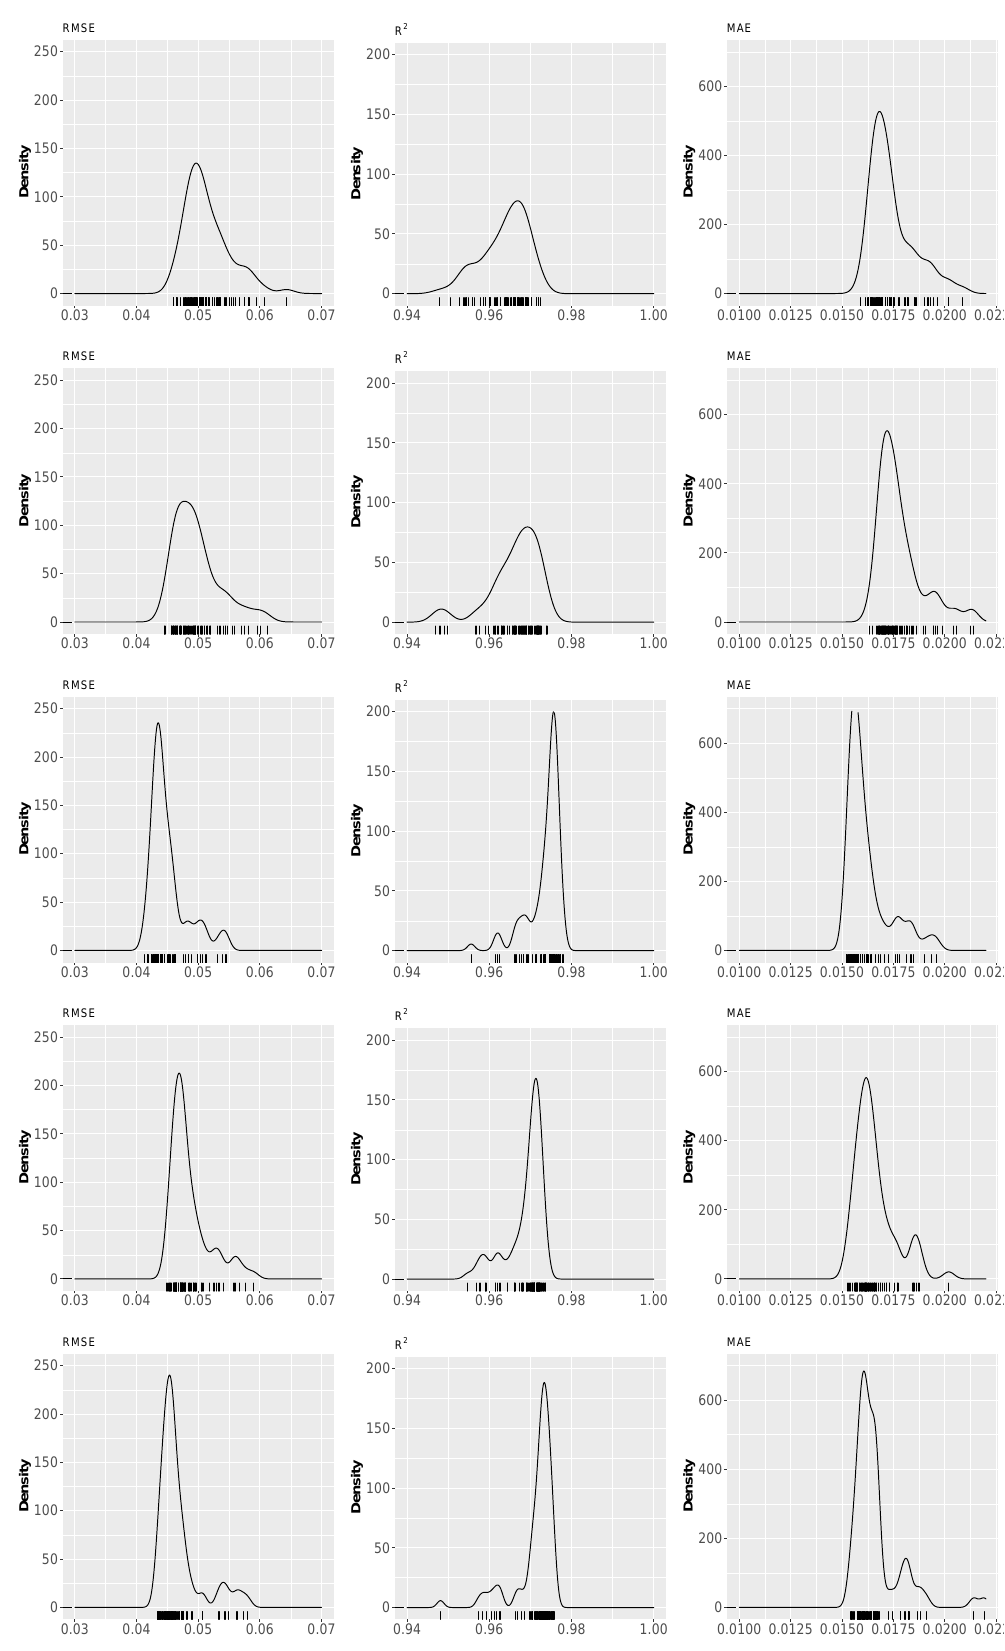
Figure 5. Density plots for (from left to right) RMSE, R 2 , and MAE resulting from the 25 bootstrap replications. From top to bottom, the number of input data goes from 7 to